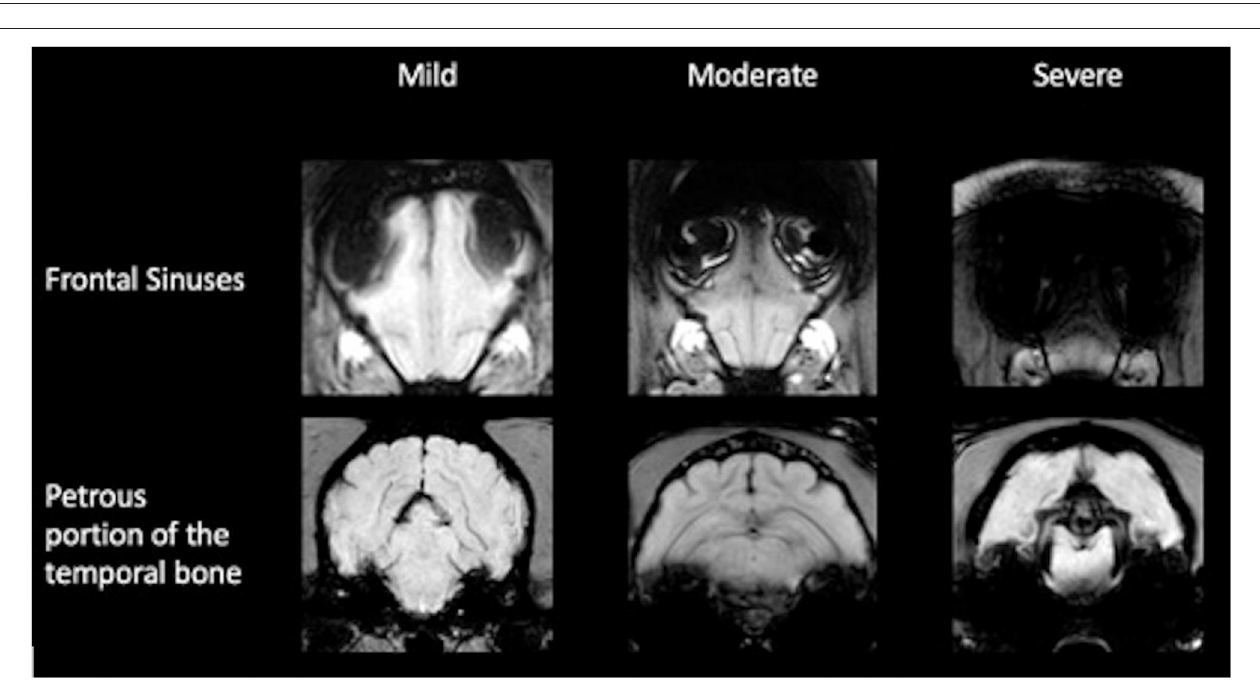
FIGURE 3 | Classification of image distortion at the level of the frontal sinuses and petrous portion of the temporal bone in susceptibility-weighted imaging.